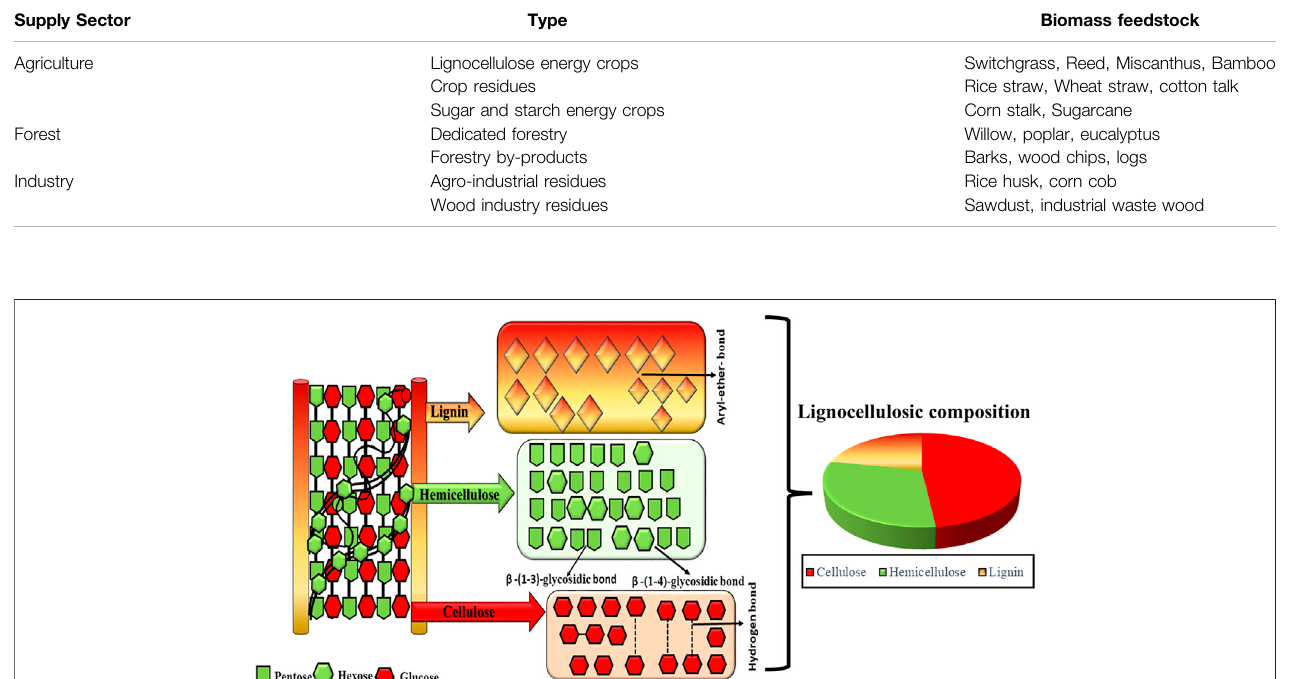
FIGURE 2 | Structural representation of lignocellulosic biomass with hemicellulose, cellulose, and lignin.